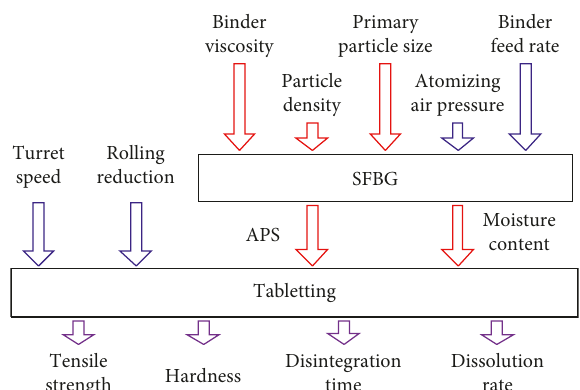
Figure 4: The framework overview of simulation modeling for SFBG-based